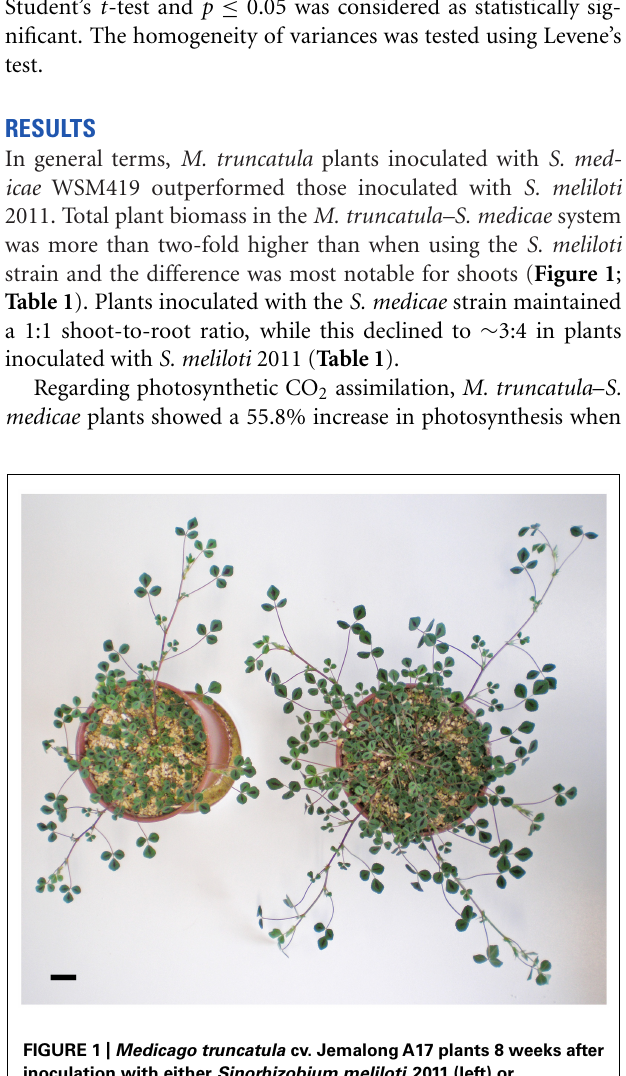
FIGURE 1 | Medicago truncatula cv. JemalongA17 plants 8 weeks after inoculation with either Sinorhizobium meliloti 2011 (left) or Sinorhizobium medicae WSM419 (right). Scale bar = 2 cm.